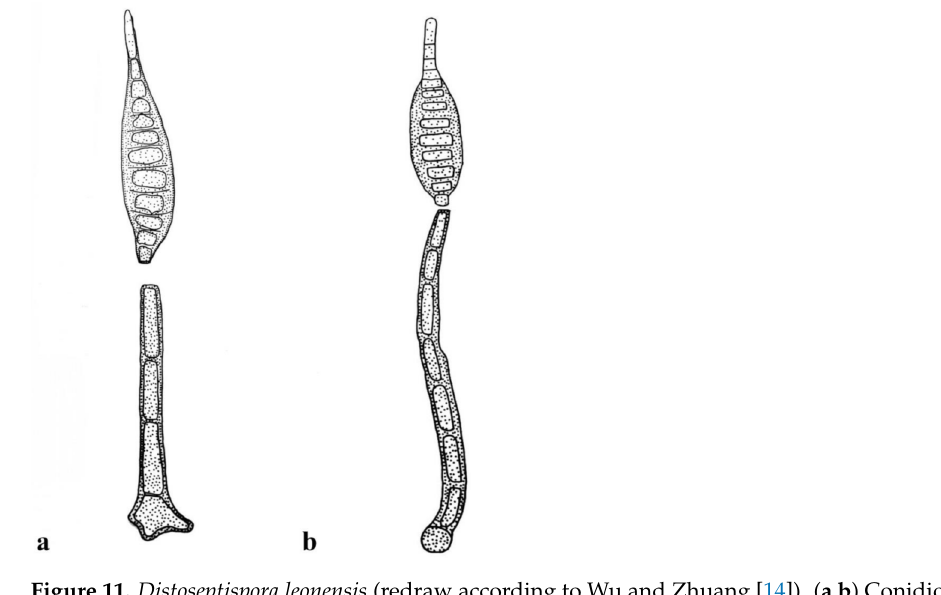
Figure 11. Distoseptispora leonensis (redraw according to Wu and Zhuang [14]). ( a , b ) Conidiophores with